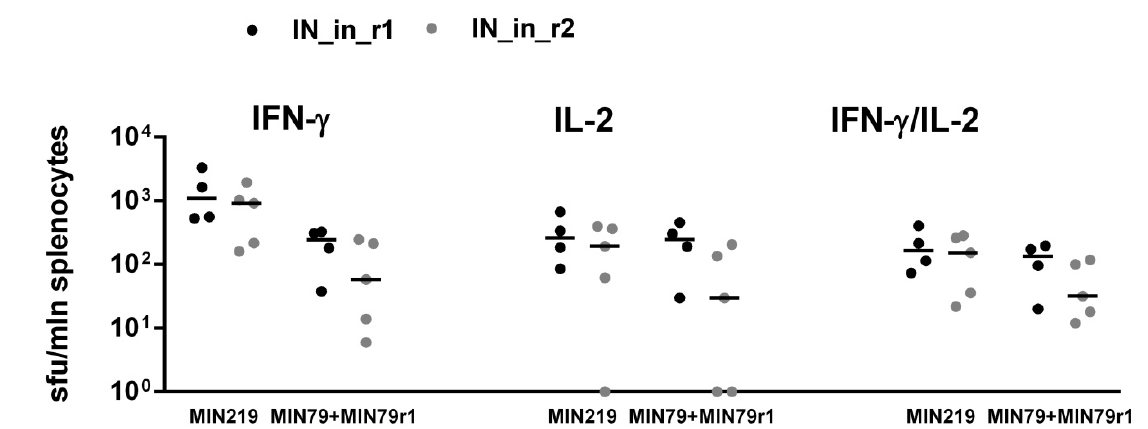
Figure 16. Splenocytes of mice DNA immunized with IN variants and implanted with murine adenocarcinoma cells ex- pressing IN, demonstrate potent IFN- γ /IL-2 response against IN epitopes at aa 79–98 (MIN79 + MIN79r1) and aa 219–238 (MIN219). For the description of immunization scheme, see Figure 14. Twenty-one days after challenge splenocytes of mice were stimulated in vitro with individual IN-derived peptides (Supplementary Table S1) for 18 h, as described in Materials and Methods. In vitro secretion of IFN- γ , IL-2, and dual secretion of IFN- γ /IL-2 was measured as the number of signal-forming units (sfu) per mln splenocytes, done in duplicates. Line bars represent the median of sfu/mln splenocytes; no statistically significant differences were registered ( p > 0.1; Mann–Whitney test).